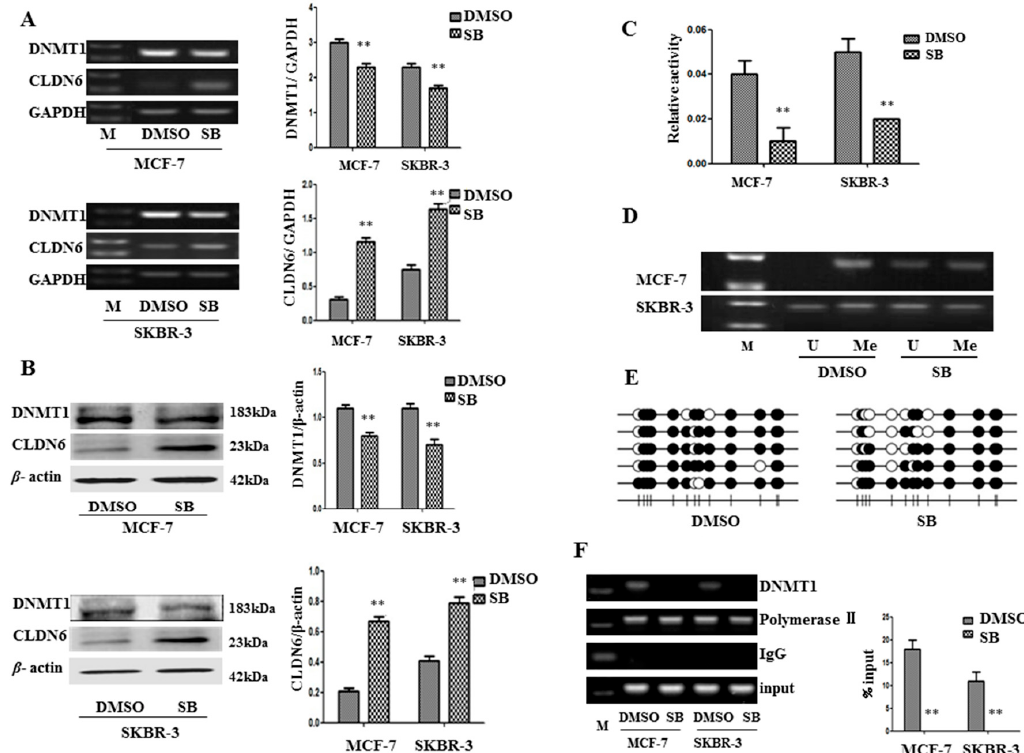
Figure 2. DNA methyltransferase 1 (DNMT1)-mediated upregulation of CLDN6 expression by SB431542. ( A , B ) Real-time polymerase chain reaction (RT-PCR) and immunoblot analysis of DNMT1 and CLDN6, and densitometric analysis of relative gene expression levels after normalization to loading controls GAPDH and β -actin are presented. ( C ) DNMT1 activity assays. ( D ) Methylation-specific PCR (MSP) analysis of CpG island of CLDN6 promoter using bisulfite-treated genomic DNA isolated from MCF-7 and SKBR-3 cells. ( E ) CpG island methylation within the CLDN6 promoter region was measured by bisulfite sequencing in SKBR-3 cells. “Me” stands for methylated, and “U” stands for unmethylated. ( F ) Chromatin immunoprecipitation-polymerase chain reaction (ChIP-PCR) assay to detect the binding of DNMT1 to the promoter of CLDN6 (** p < 0.01). The lane “M” stands for marker; bars represent mean ± SE ( n = 3).